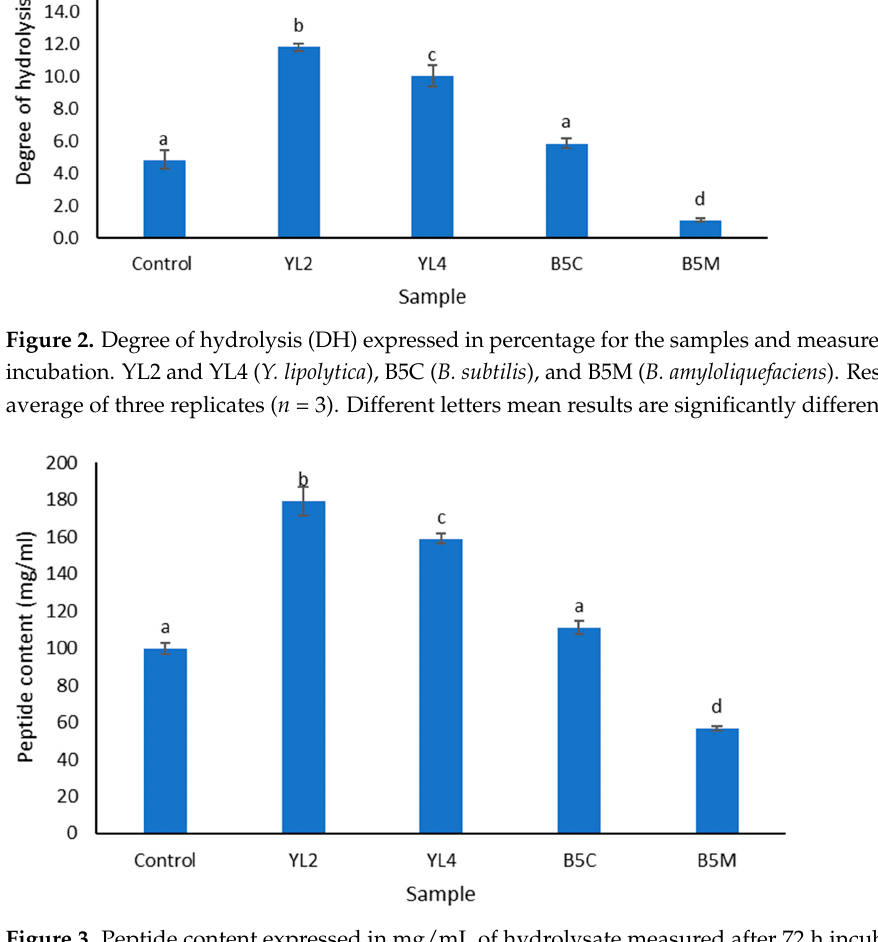
Figure 3. Peptide content expressed in mg/mL of hydrolysate measured after 72 h incubation. YL2 and YL4 ( Y. lipolytica ), B5C ( B. subtilis ), and B5M ( B. amyloliquefaciens ). Results are the average of three replicates ( n = 3). Different letters mean results are significantly different ( p < 0.05).